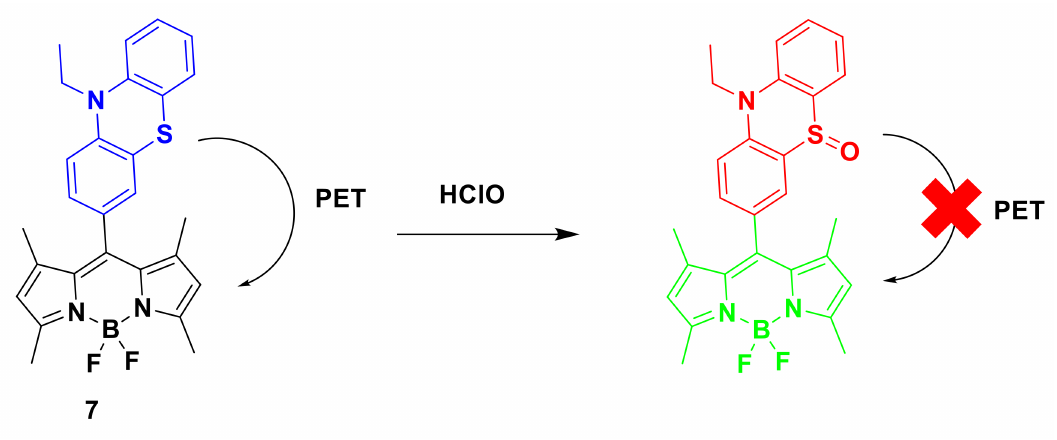
Figure 8. The reaction of probe 7 and